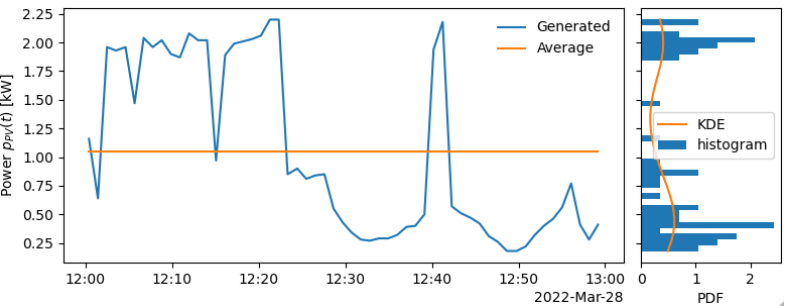
Figure 25. Close-up in time with the associated power histogram and KDE